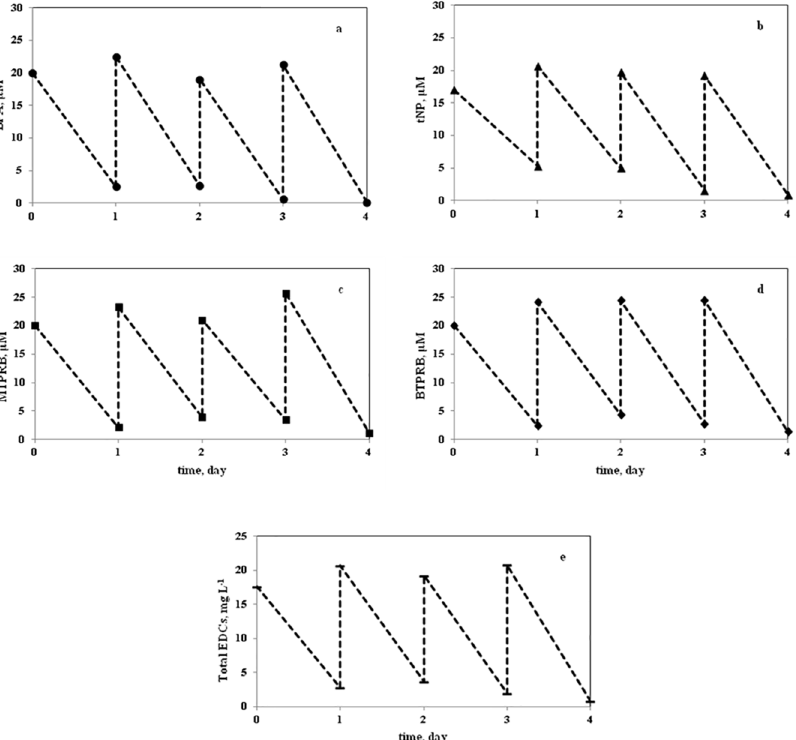
Fig 5. Concentration ( μ M) of individual EDCs (applied in mixture) (panel a-d) as measured in the bubble column bioreactor as function of the time. Panel e shows the sum concentration (mg L -1 ) of EDCs measuredin the bioreactor. The concentration peaks correspondto the cyclic feedingwith fresh